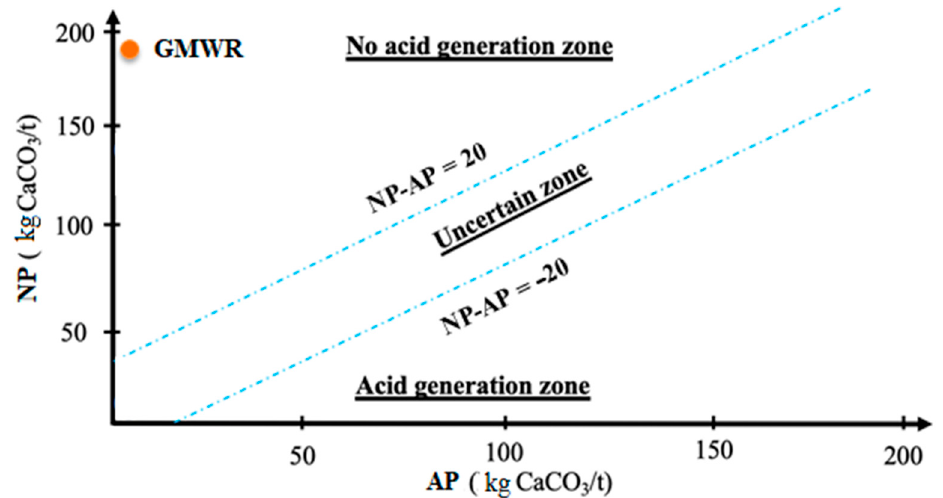
Figure 7. Illustration of the location of GMWR samples .